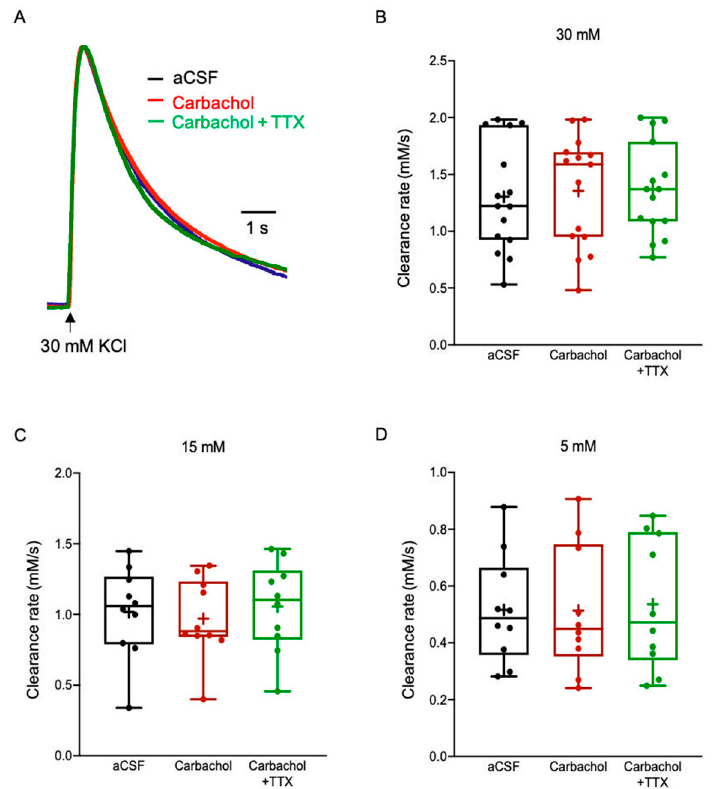
Figure 7. The impact of Carbachol on the K + clearance rate and astrocytic Ca 2+ signalling. ( A ) Sample traces of [K + ] o recordings depicting the K + clearance time course following local application of 30 mM KCl (arrow), before (aCSF, blue) and after application of Carbachol (100 µ M, red) or Carbachol with 1 µ M TTX (green).( B – D ) Box plots depicting the K + clearance rate following local application of KCl at 30 mM ( B ), 15 mM ( C ) and 5 mM ( D ), before (aCSF, black dots) and after bath application of Carbachol (100 µ M) without (red dots) or with TTX (green dots). Box plot definitions is the same as in Figure